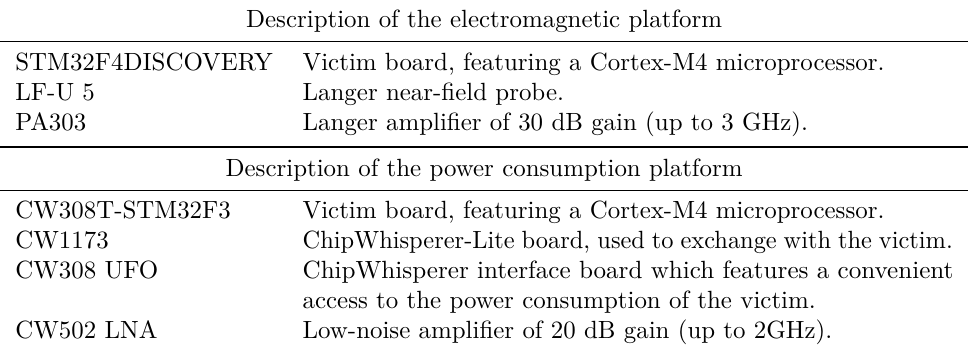
Table 4: Specific equipment used to measure experimental side-channel